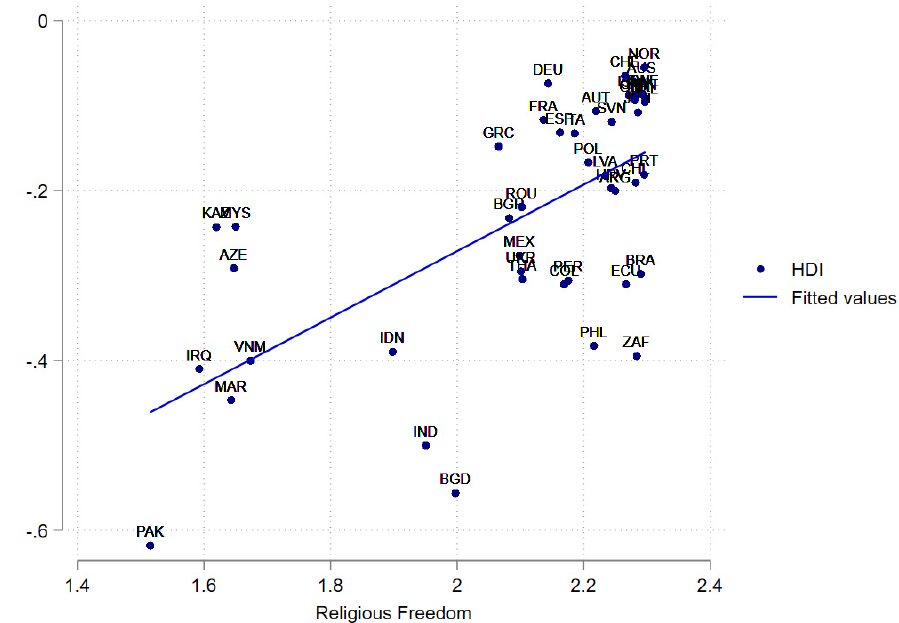
Figure 5. The HDI and Religious Freedom .